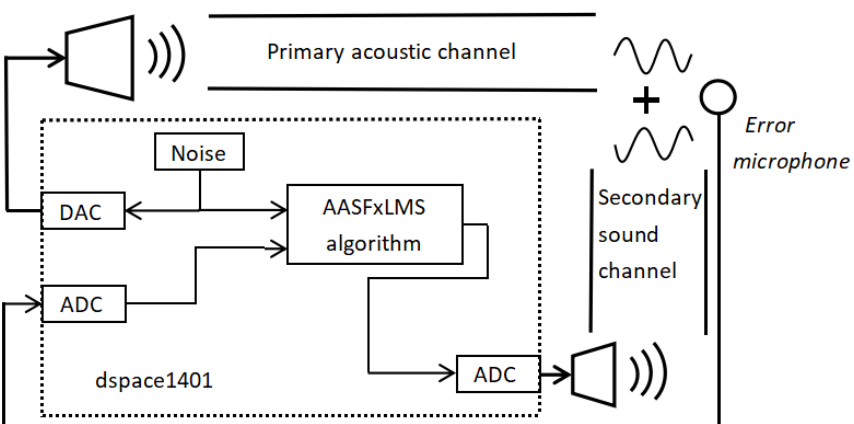
Figure 11. Real-time vehicle noise signal acquisition.